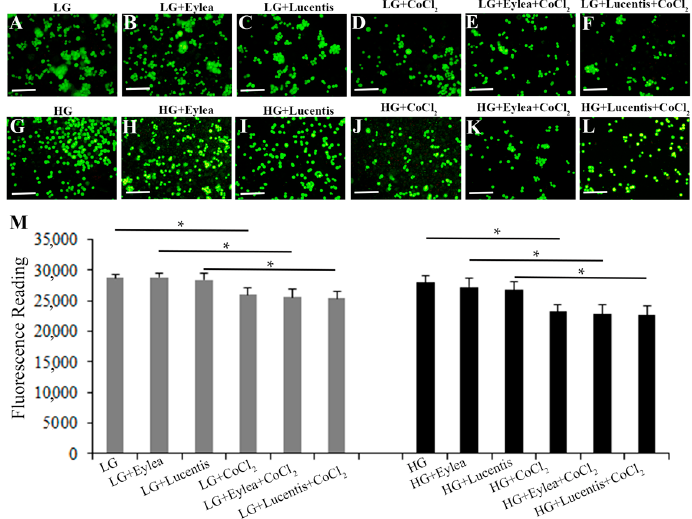
Figure 4. Aflibercept and ranibizumab did not affect Y79 photoreceptor cell survival under stress conditions. ( A – L ) Fluorescence images of calcein-AM-stained Y79 cells exposed to stress media containing LG (11 mM) or HG (25 mM) for 24 h. Scale bars: 50 µm; ( M ) Quantitative analysis of Y79 cell viability by measuring the fluorescence intensity after staining Y79 cells with calcein-AM. * p < 0.05, n = 6/group.